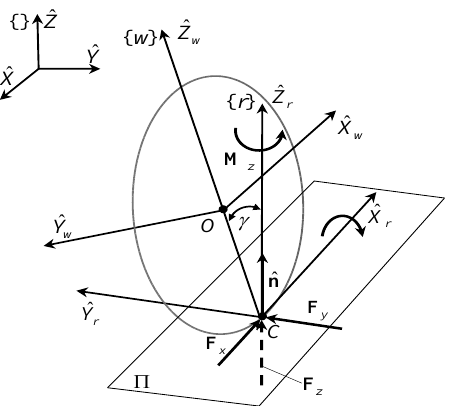
Figure 14. Road surface reaction forces: F 𝑥 —longitudinal force (rolling resistance), F 𝑦 —lateral force, M 𝑧 —aligning torque